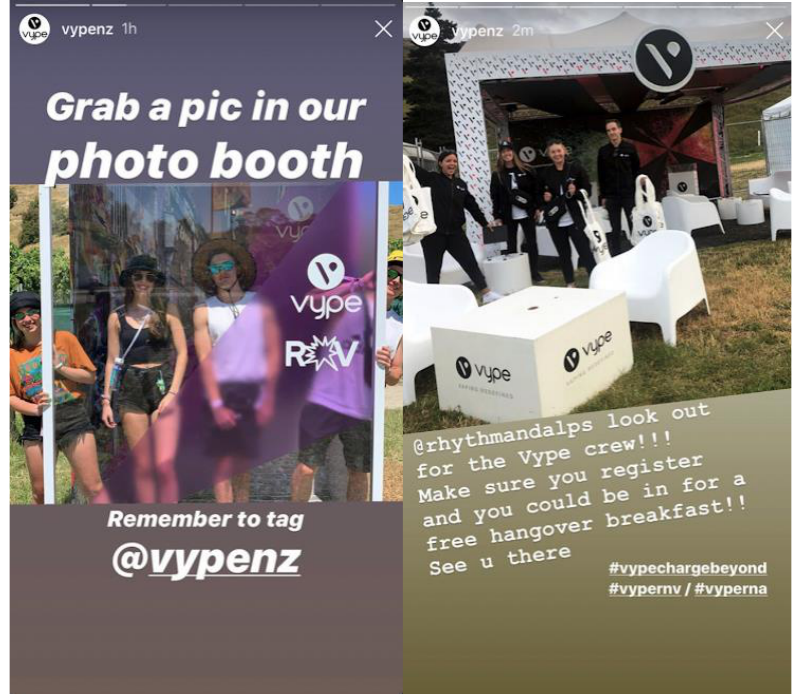
Figure 8. Example of Instagram Stories.